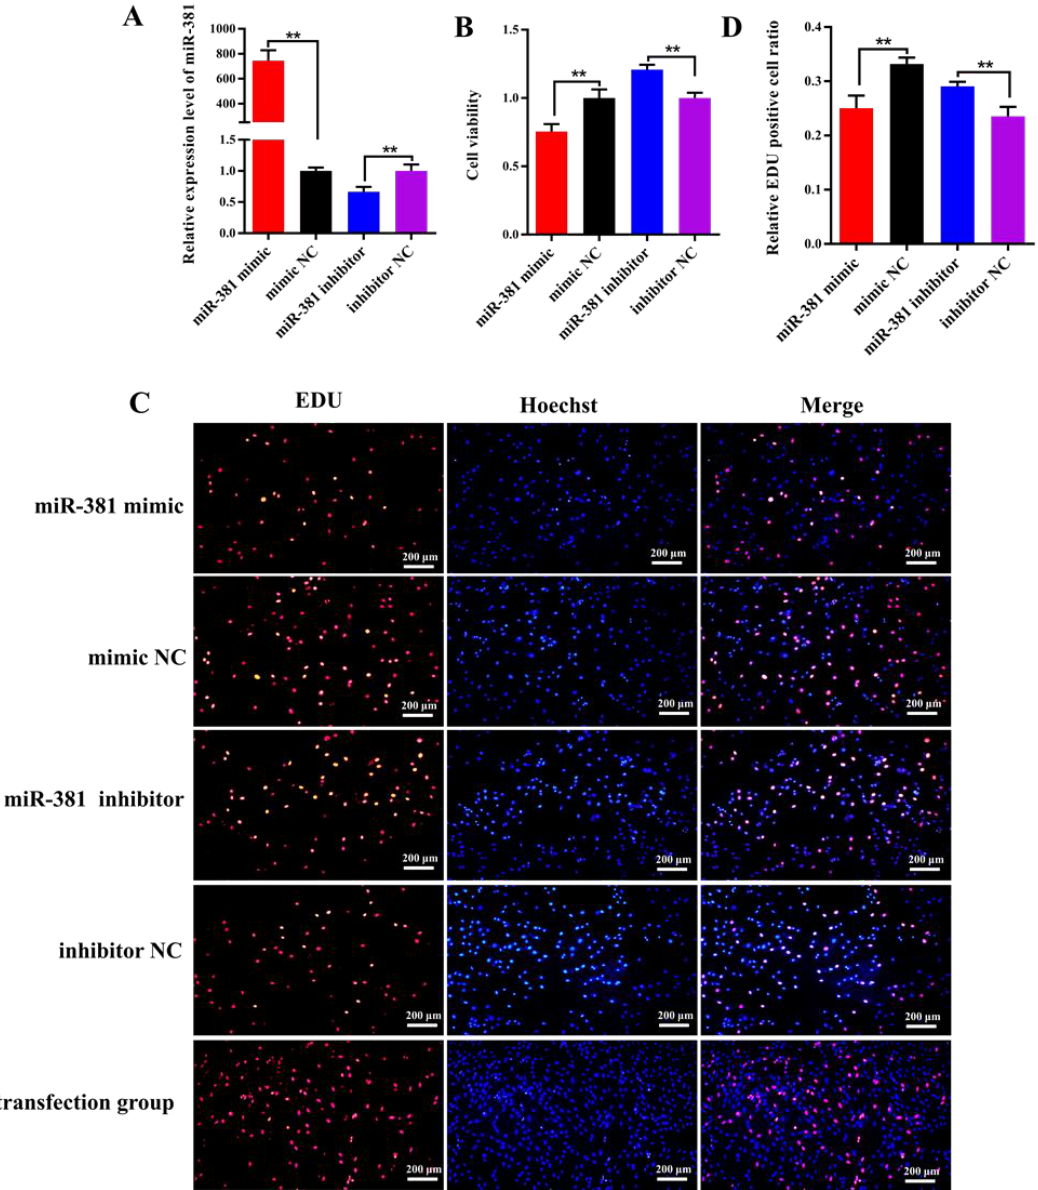
Figure 3. The miR-381 suppressed the viability and proliferation of caprine skeletal muscle satellite cells (SMSCs). ( A ) Transfection efficiency detection of miR-381 mimic and miR-381 inhibitor. ( B ) The effect of miR-381 on the viability of caprine SMSCs when miR-381 mimic and miR-381 inhibitor were transfected into SMSCs. ( C ) The effect of miR-381 on the proliferation of SMSCs detected using EDU assay. EDU, Hoechst and Merge represent the number of EDU-positive SMSCs, the total number of SMSCs and the proportion of EDU-positive SMSCs in the total SMSCs, respectively. ( D ) The percentage of EDU-positive SMSCs counted by ImageJ software. ** p < 0.01. To further evaluate the effect of miR-381 on SMSC proliferation, the expression levels of three proliferation marker genes were measured in SMSCs transfected with miR-381 mimic and miR-381 inhibitor. The results showed that the expression levels of myogenic factor 5 ( Myf5 ) and cyclin D1 ( CCND1 ) were decreased in caprine SMSCs transfected with